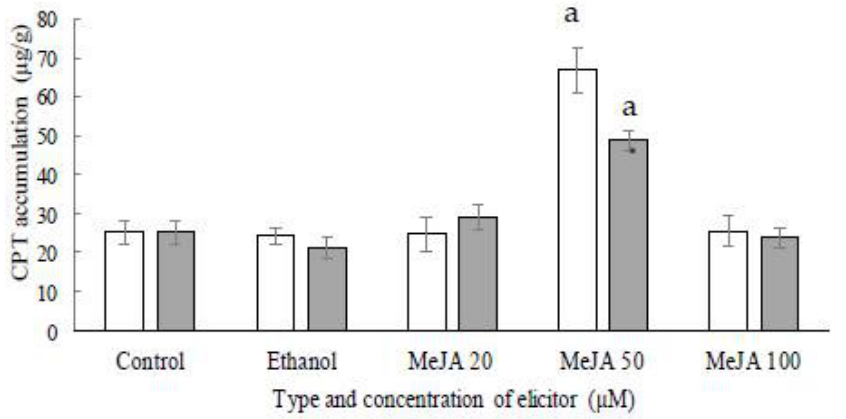
Figure 5. Effects of MeJA elicitation on CPT concentration in stems by elicitation with ethanol and MeJA (20, 50 and 100 µM) for 12 h (□) and 24 h ( ■ ) before harvesting. The values are expressed as mean ± SD ( n = 3); a: significant at p < 0.05 vs. control.